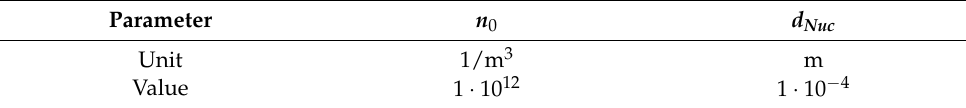
Table 1. Parameters of the Schnerr-Sauer cavitation